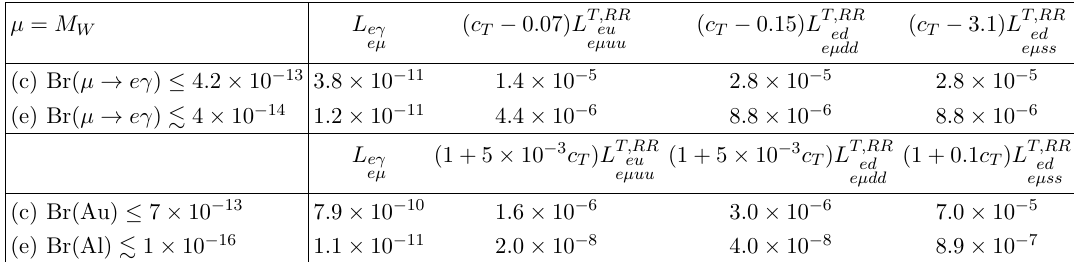
Table 3 . Current (c) and expected (e) limits from (cid:22) ! e(cid:13) and (cid:22) ! e conversion experiments on the coe(cid:14)cients of the dipole and tensor operators at the scale (cid:22) = M W . The (cid:12)rst and fourth rows indicate the combinations of Wilson coe(cid:14)cients and the LEC c T that are constrained by each observable. The limits are given in units of TeV (cid:0) 2 for the tensor operators, while those for L e(cid:13) in units of TeV (cid:0) 1 . The linear combinations (1 + 5 (cid:2) 10 (cid:0) 3 c T ) etc. di(cid:11)er by about 10% between Au and